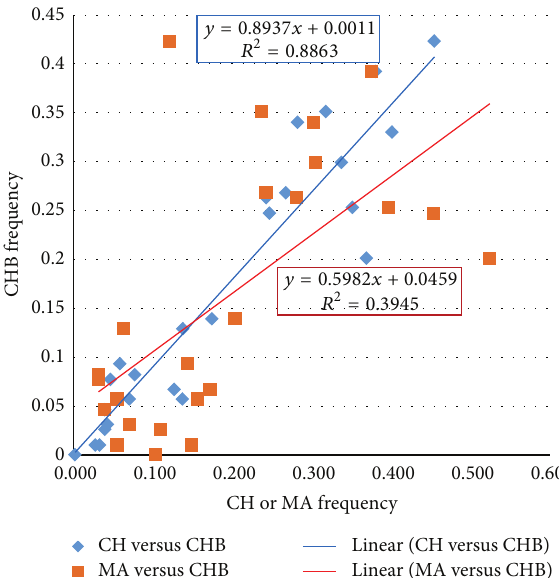
Figure 3: Comparison of allele frequencies of the top 25 SNPs from CH versus HapMap Chinese from Beijing (CHB) and MA versus